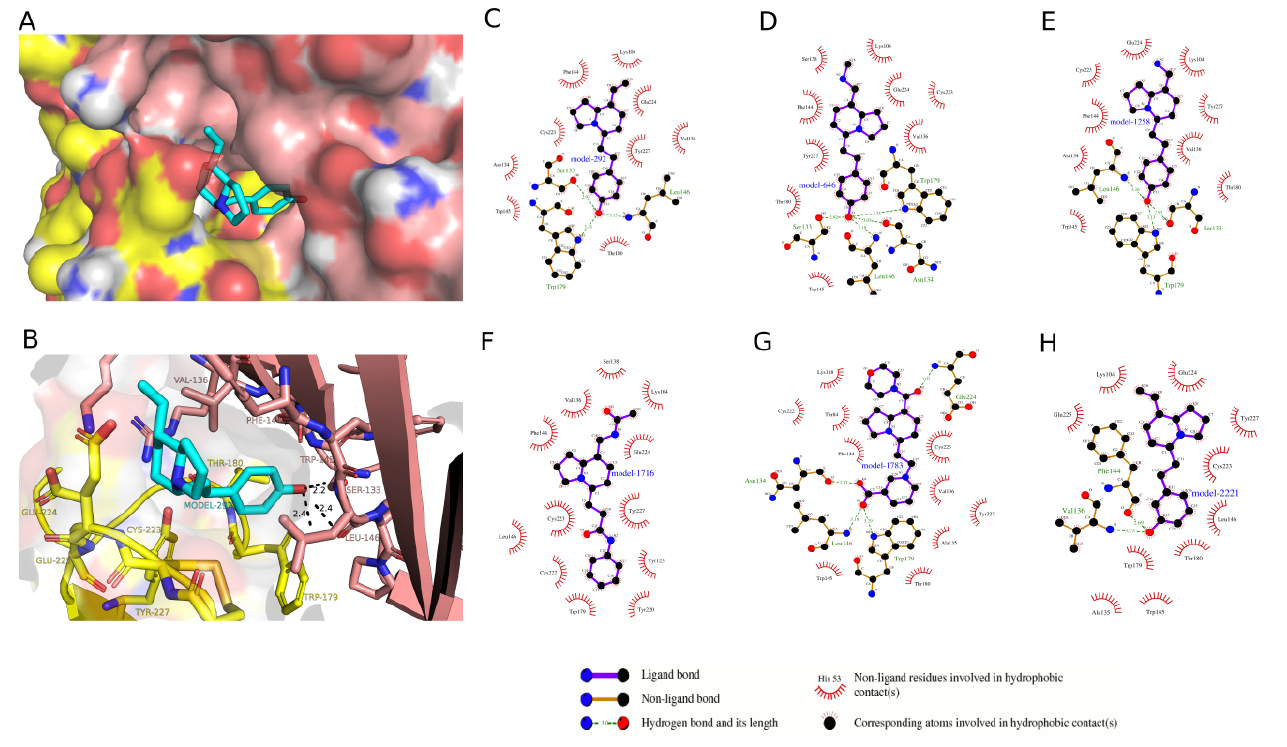
Figure 4. Receptor–analog interactions using PyMOL and LigPlot. ( A ) The docked pose of model-292 in the binding pocket of α 6 β 2 nAChR. Model-292 is shown as a stick model with cyan-colored carbon atoms; the receptor is shown as a molecular surface. ( B ) Model-292 interactions with binding pocket residues. Model-292 is shown as a stick model; α 6 chain residues are shown as yellow sticks whiles that of β 6 chain residues are shown as brown sticks. ( C – H ) LigPlot diagrams of the interactions between top-ranked compounds and the binding site residues of the α 6 β 2